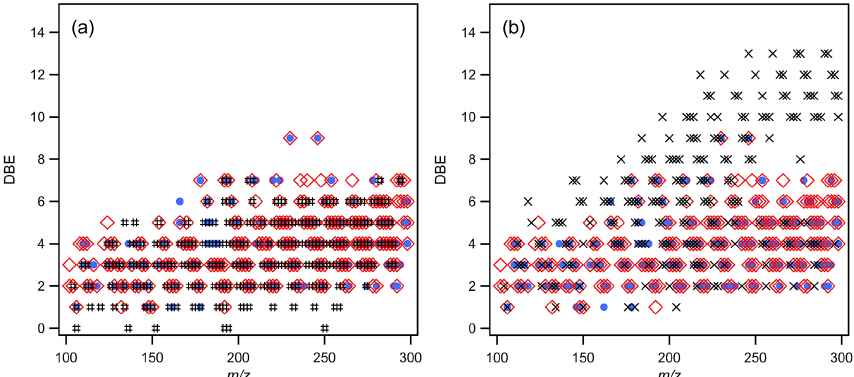
Fig. 4. Double bond equivalents (DBE) vs. mass to charge ( m/z) ratios for all compounds containing only carbon, hydrogen and oxygen in the samples from (a) α -pinene/O 3 , BVOC mixture/O 3 experiments and boreal forest, Hyytiälä, Finland, and (b) α -pinene/O 3 , BVOC mixture/O 3 experiments and Tivoli Industrial Estate and Docks, Cork, Ireland. Filled blue circles correspond to species from α -pinene/O 3 experiment, red diamonds to BVOC mixture/O 3 experiments, black hashes to the Hyytiälä samples and black crosses to the Tivoli Industrial Estate and Docks, Cork